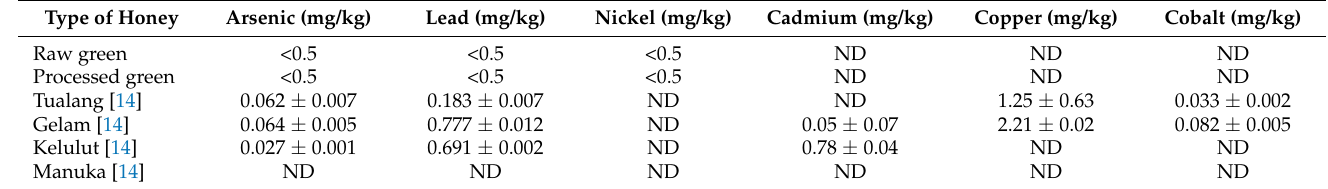
Table 4. Analysis of metal content in green honey compared with honeys from various